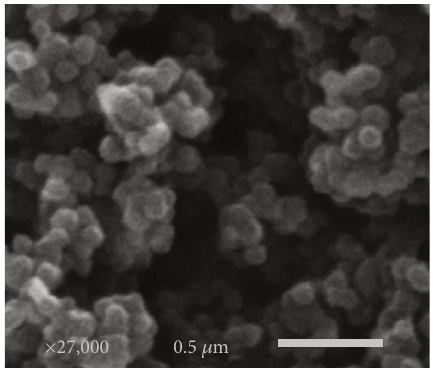
× 27,000 0.5 𝜇 m Figure 2: SEM micrograph of synthesized chitosan